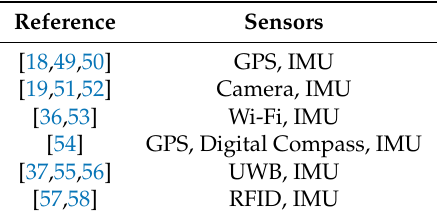
Table 1. Some references of navigation